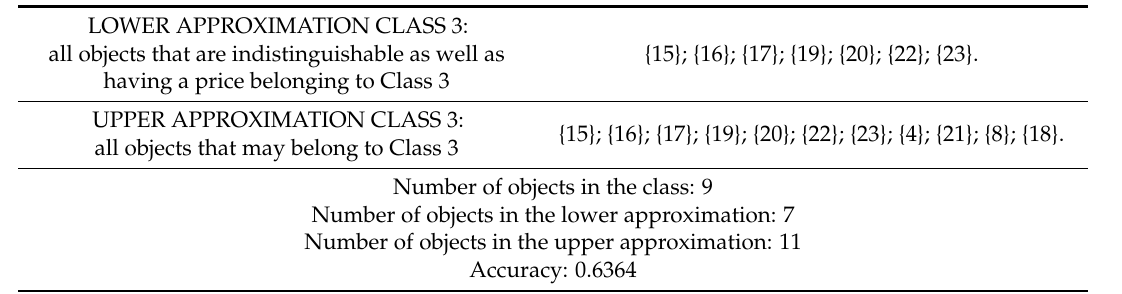
Table 7. Lower and upper approximations for Price Class